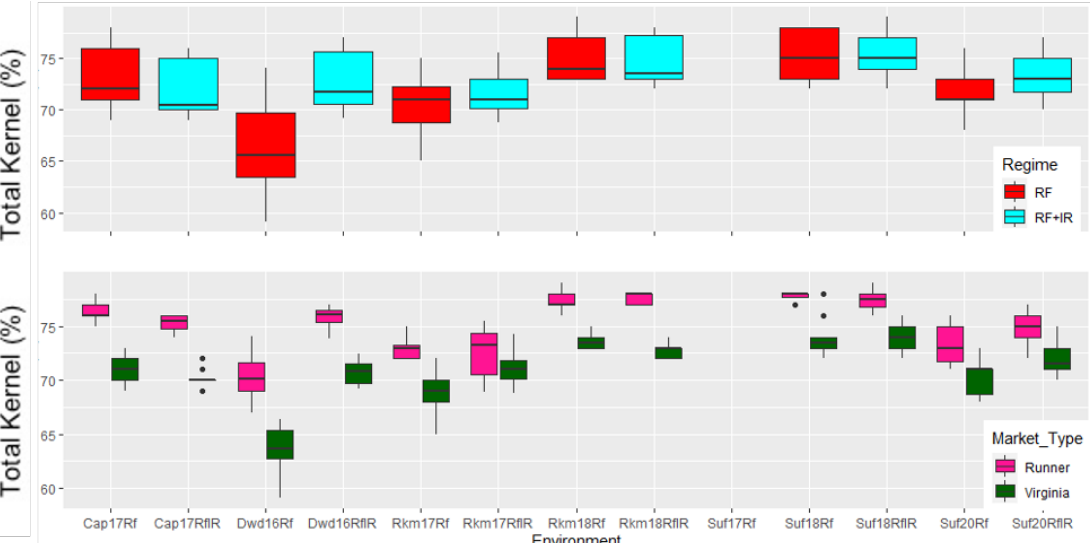
Figure 6. Boxplot for the effect of water regime and market type on total kernels (TK) of 5 Virginia and runner peanut cultivars in 13 environments. Each plot indicates total range, interquartile range (box), and median (line). Environment names are coded and the first three letters indicate location: Cap, Capron, VA; Dwd, Dinwiddie, VA; RM, Rocky Mount, NC; Suf, Suffolk, VA; two digits indicate year of the trial; 16 for 2016, 17 for 2017, 18 for 2018, 20 for 2020; and the last letters Rf and RfIR for water regime: Rf, rainfed, RfIR, rainfed plus irrigated. The upper part of the figure shows the effect of water regime and the lower part the effect of market type on the total kernels (TK) content.